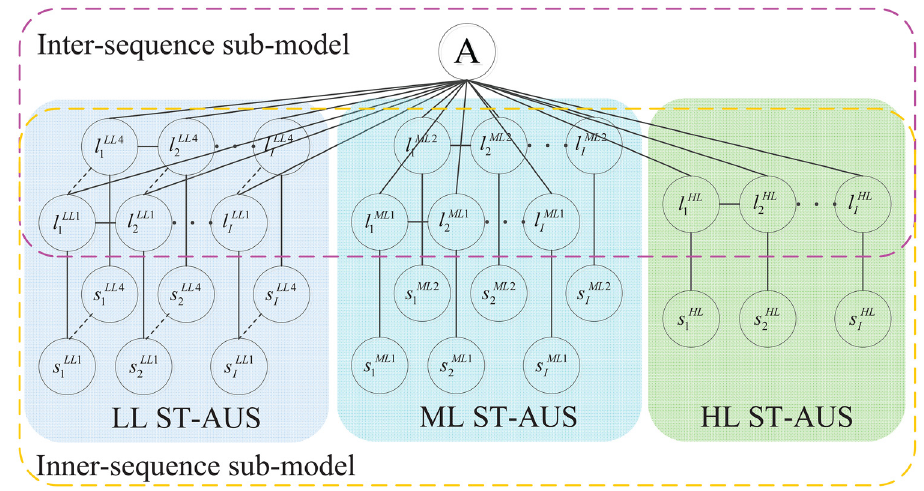
Fig 3. Graph structure of MTCRFs.